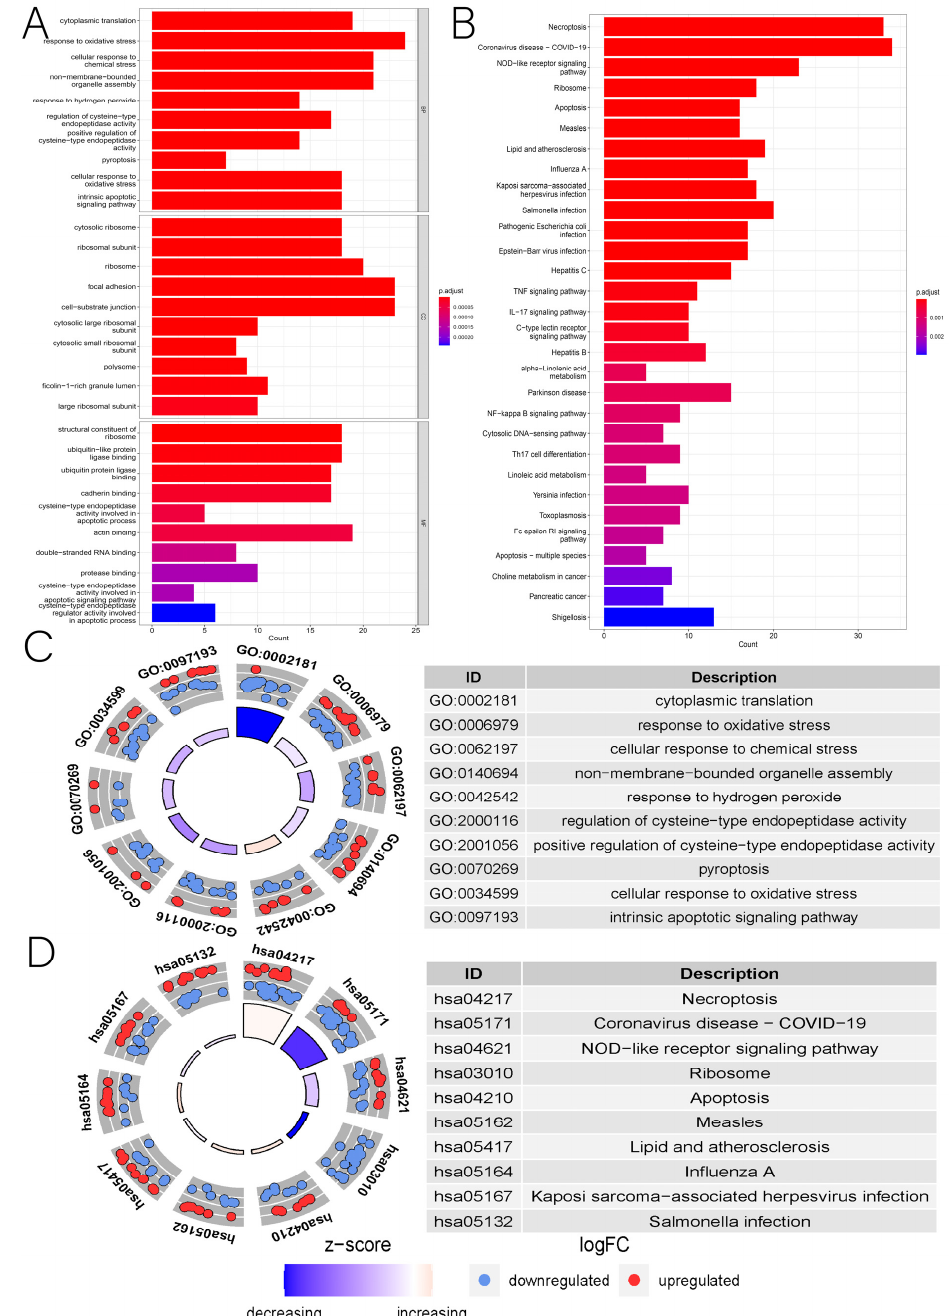
Figure 3. ( A ) Bar graph of GO enrichment analysis. ( B ) Bar graph of KEGG pathway enrichment analysis. ( C ) Circle diagram of GO enrichment analysis. ( D ) Circle diagram of KEGG pathway enrichment analysis.